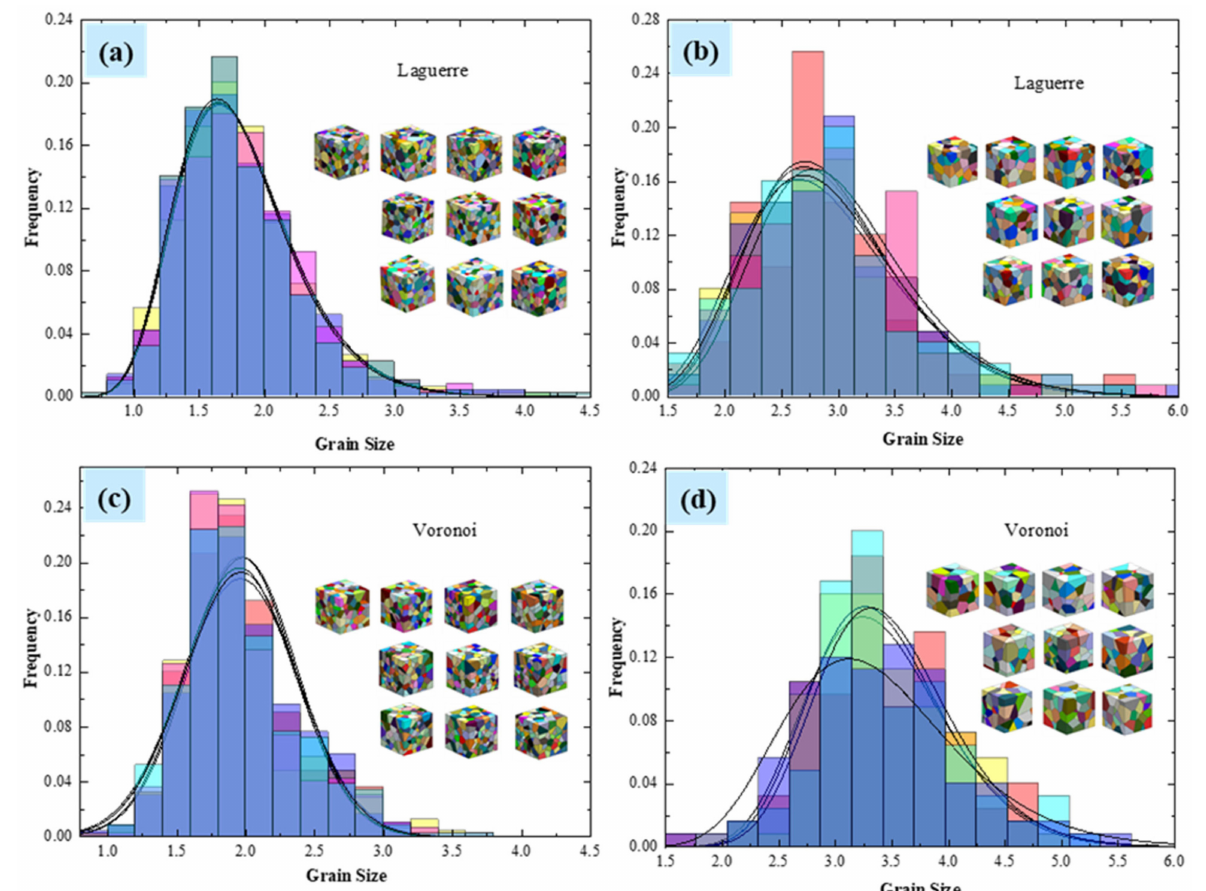
Figure 9. ( a ) Grain size distribution of the Laguerre–Voronoi tessellation polycrystalline model with 500 grains; ( b ) grain size distribution of the Laguerre–Voronoi tessellation polycrystalline model with 125 grains; ( c ) grain size distribution of the Voronoi tessellation polycrystalline model with 500 grains; ( d ) grain size distribution of the Voronoi tessellation polycrystalline model with 125